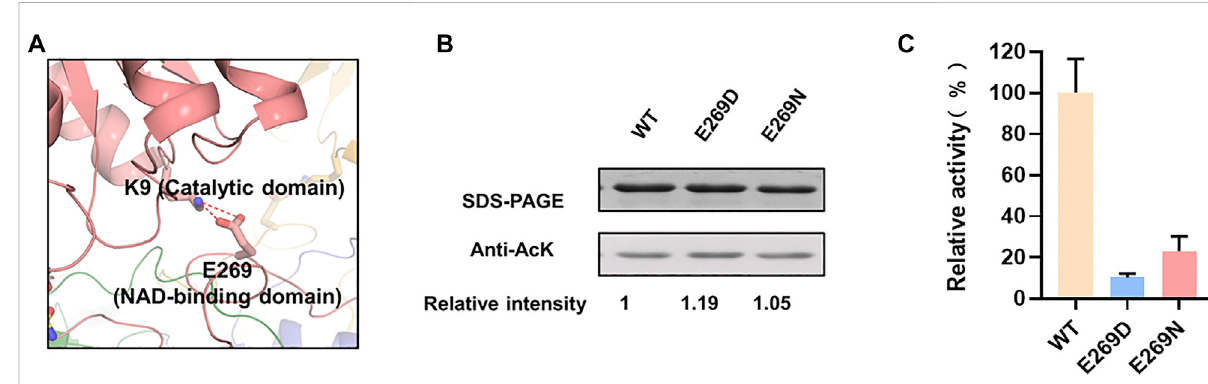
FIGURE 3 ThemechanismofK9acetylationonenzymeactivity. (A) ThesaltbridgeofK9-E269inmonomer. (B) TheacetylationlevelsofE269mutants. (C) The enzyme activities of E269 mutants.